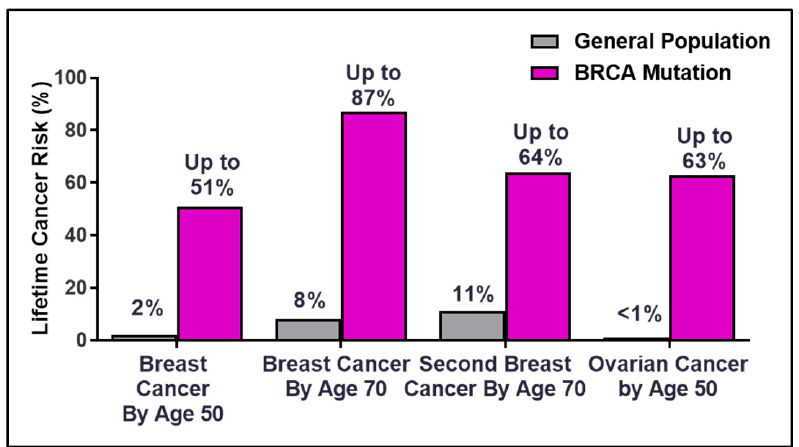
Figure 1. Percentages of lifetime breast and ovarian cancer risks in BRCA germline carriers.